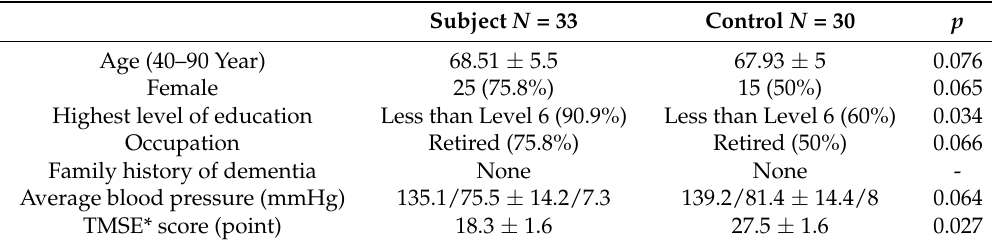
Table 1. Characteristic Data.